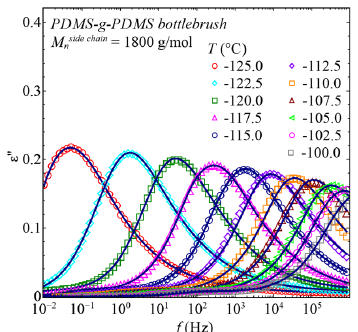
Fig. 5. Imaginary part of the dielectric permittivity, 𝜖′′ , as a function of frequency, 𝑓 , for Sample 2 for different temperatures as indicated. Solid lines are the best descriptions with Havriliak Negami functions. Data has been previously published in Jakobi et al